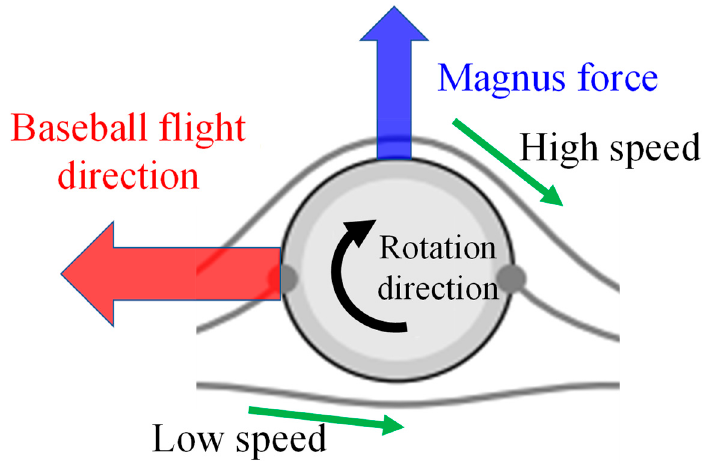
Figure 3. Magnus force effect during baseball flight.